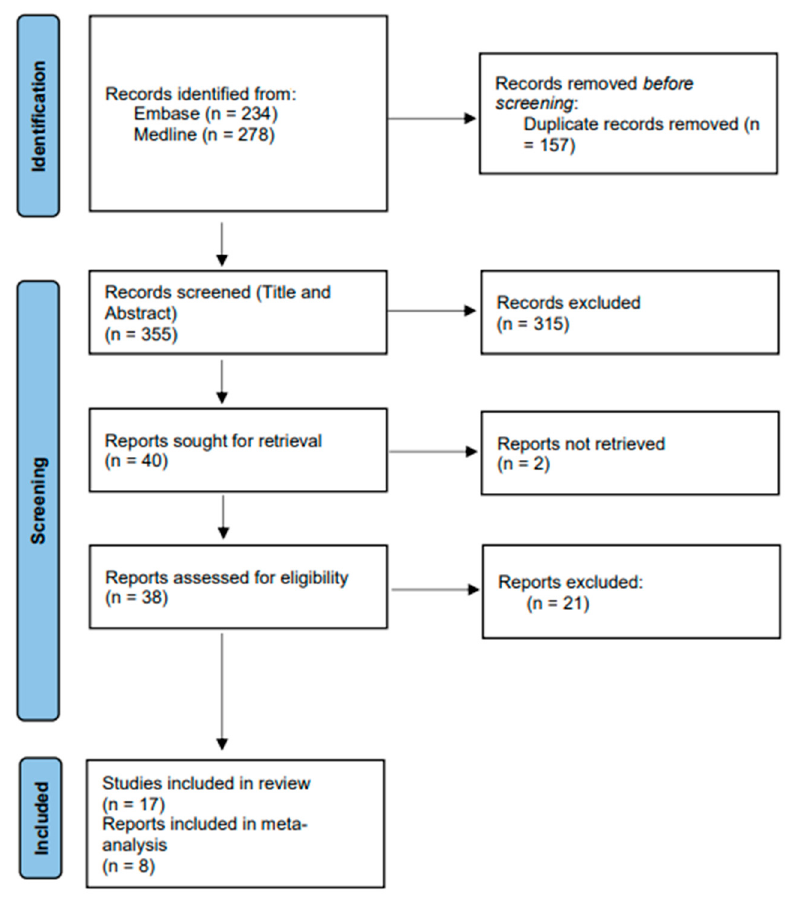
Figure 1. PRISMA flow chart of studies included in this systematic review.